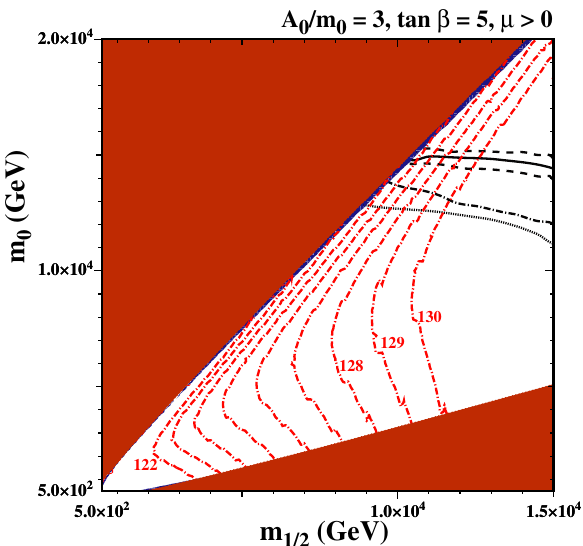
Fig. 6 Sensitivity to m c for μ > 0, assuming tan β = 5, A 0 / m 0 = 3 and M in = M GUT . The dashed lines correspond to the variation of m c within one standard deviation ( m c = 1 . 27 ± 0 . 02 GeV) and the dotted line corresponds to the combined uncertainty from the hadronic matrix elementsand α s .Thedot-dashedcurveshowsthepositionofthelifetime limit when the 1-loop correction to m c is removed